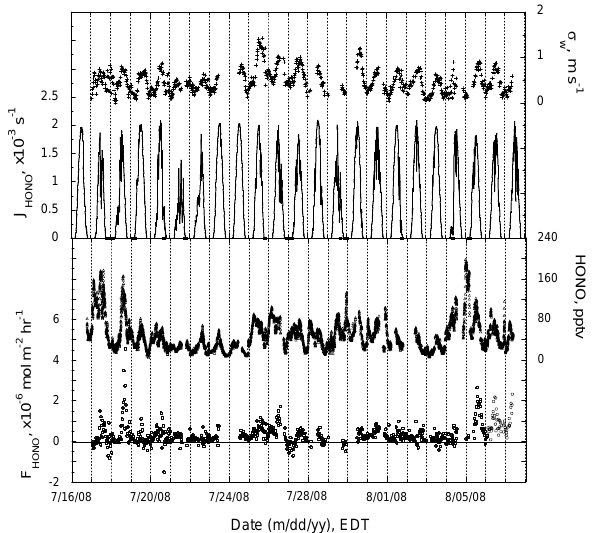
Fig. 5. Time-series of HONO flux (open circles, lower panel, left axis), ambient HONO concentration (open triangles, lower panel, right axis), J HONO (line, upper panel, left axis), and σ w (cross, up- per panel, right axis). The thick horizontal lines at the bottom of the upper panel indicate the periods of rain, mist/fog, or dew